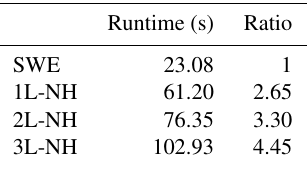
Table 6. Execution times in seconds for SWE and non-hydrostatic GPU implementations. Ratios compared with SWE.